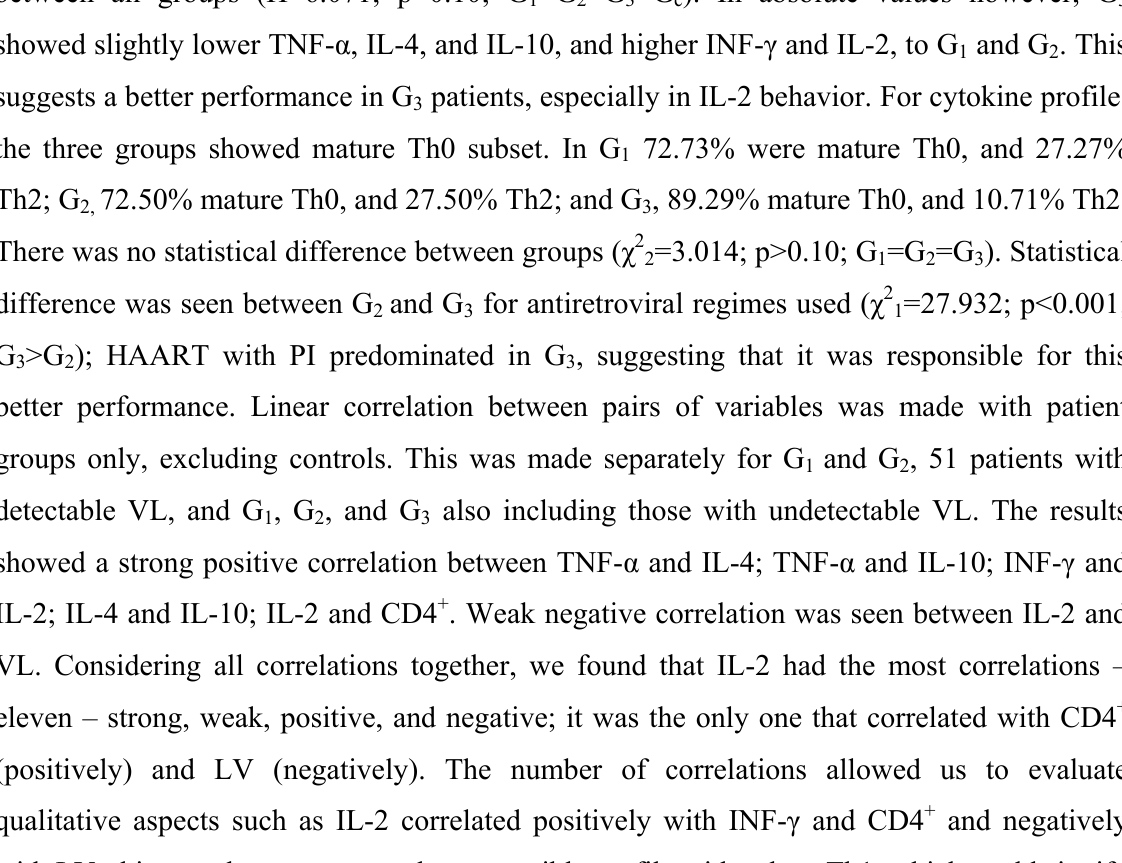
D. A. Meira et al. CORRELATION BETWEEN CYTOKINE SERUM LEVELS, NUMBER OF CD4 + T CELLS/mm³ AND VIRAL LOAD IN HIV-1 INFECTED INDIVIDUALS WITH OR WITHOUT ANTIRETROVIRAL THERAPY. J. Venom. Anim. Toxins incl. Trop. Dis. , 2004, 10, 3,